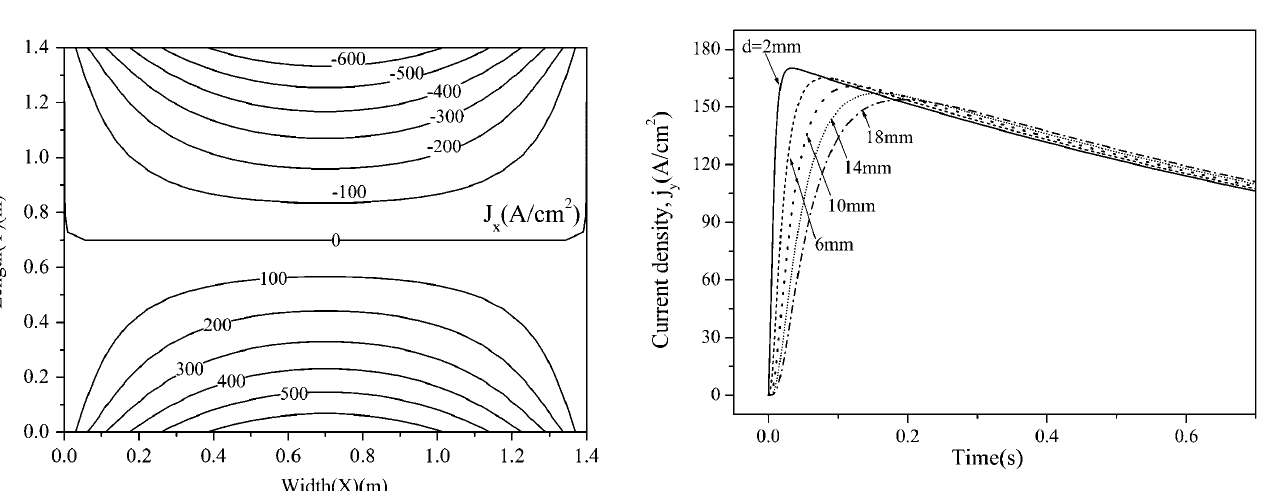
FIG. 7. Contour plot of X component of the eddy current density,